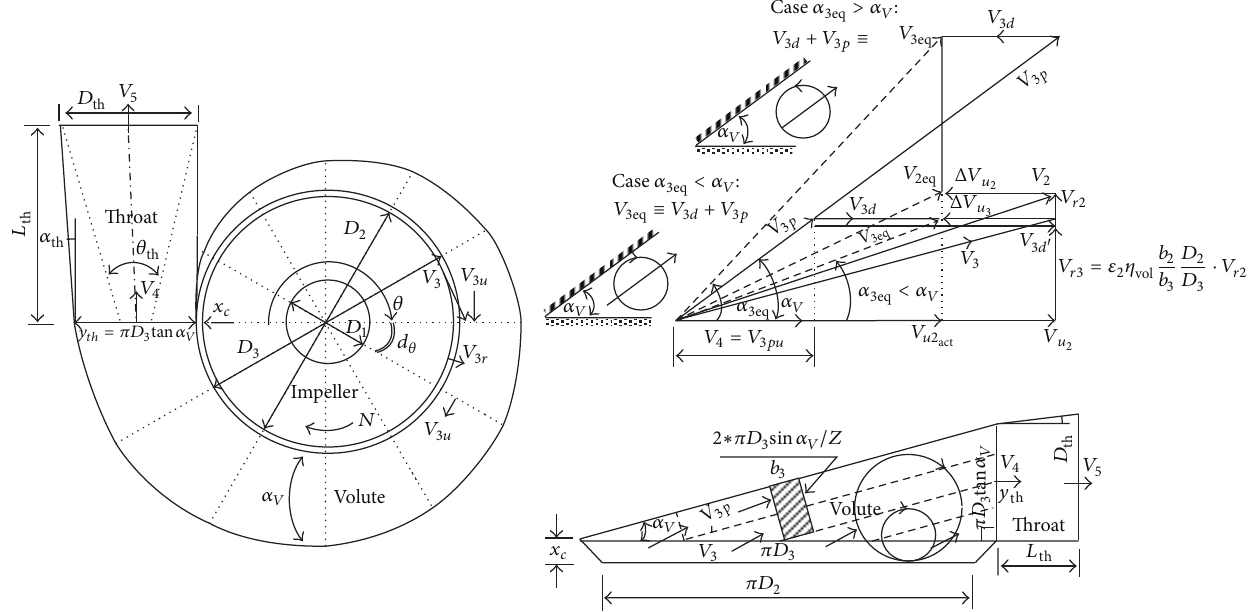
Figure 6: Pump and volute